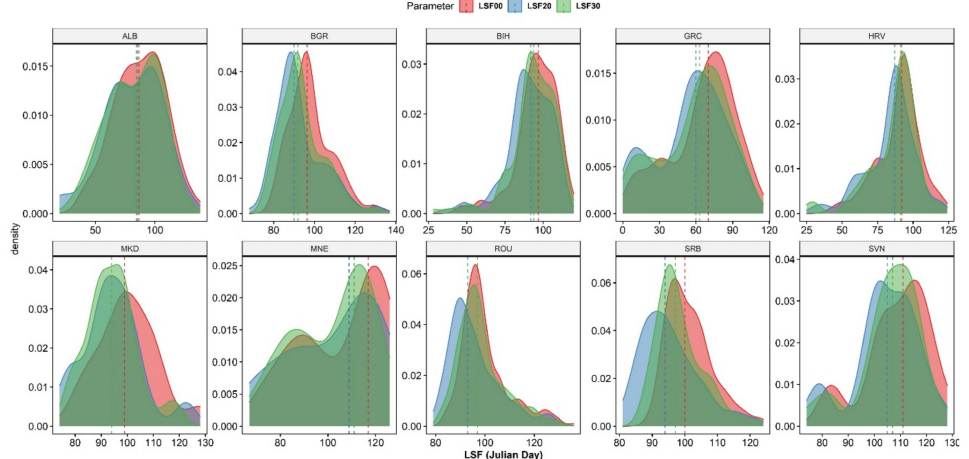
Figure 7. The density plots of the Last Spring Frost (LSF) Julian day for the reference period and the 2020 and 2030 horizons, per country. The vertical lines represent the median